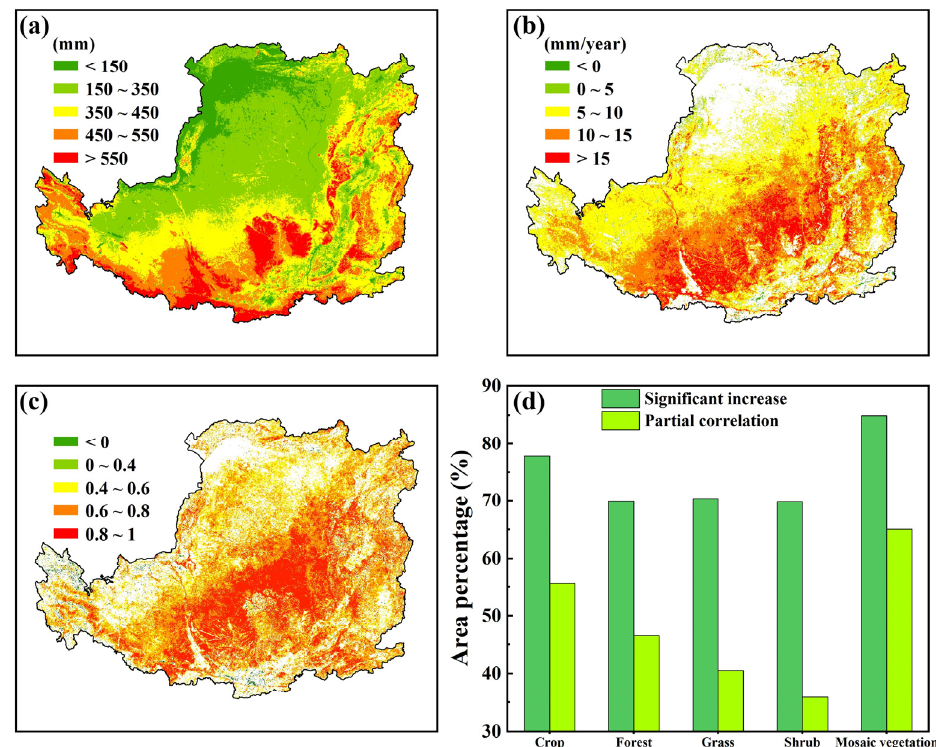
Figure 3. ( a ) The spatial distribution of the mean annual ET on the LP during 2000–2015; ( b ) the spatial features of the annual trend of ET with a statistically significant level of 0.05; ( c ) the spatial distribution of the partial correlation coefficients between ET and LAI eliminating the influences of precipitation and temperature, with a statistically significant level of 0.05; and ( d ) the area percentage of the region exhibiting an upward trend of ET and partial correlation coefficients greater than 0.6 between the LAI and ET, with a statistically significant level of 0.05.